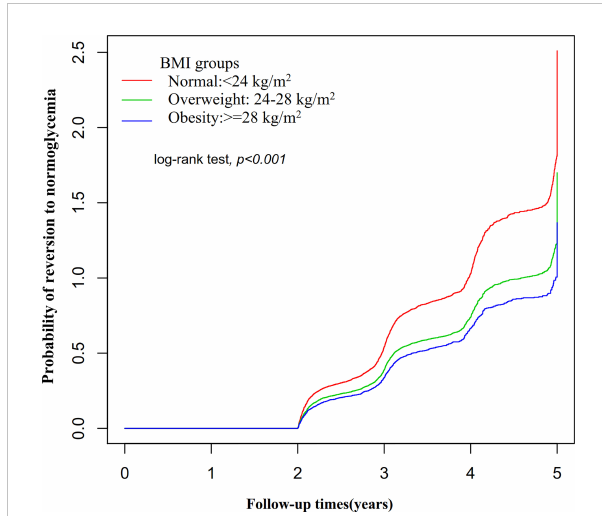
FIGURE 5 Kaplan-Meier curves for the probability of reversion to normoglycemia from IFG. Figure showed the Kaplan-Meier curves for the probability of reversion to normoglycemia from IFG strati fi ed by BMI category. The probability of reversion to normoglycemia decreased progressively with rising BMI, meaning that Patients with the highest BMI had the lowest probability of reverting from IFG to normoglycemia.